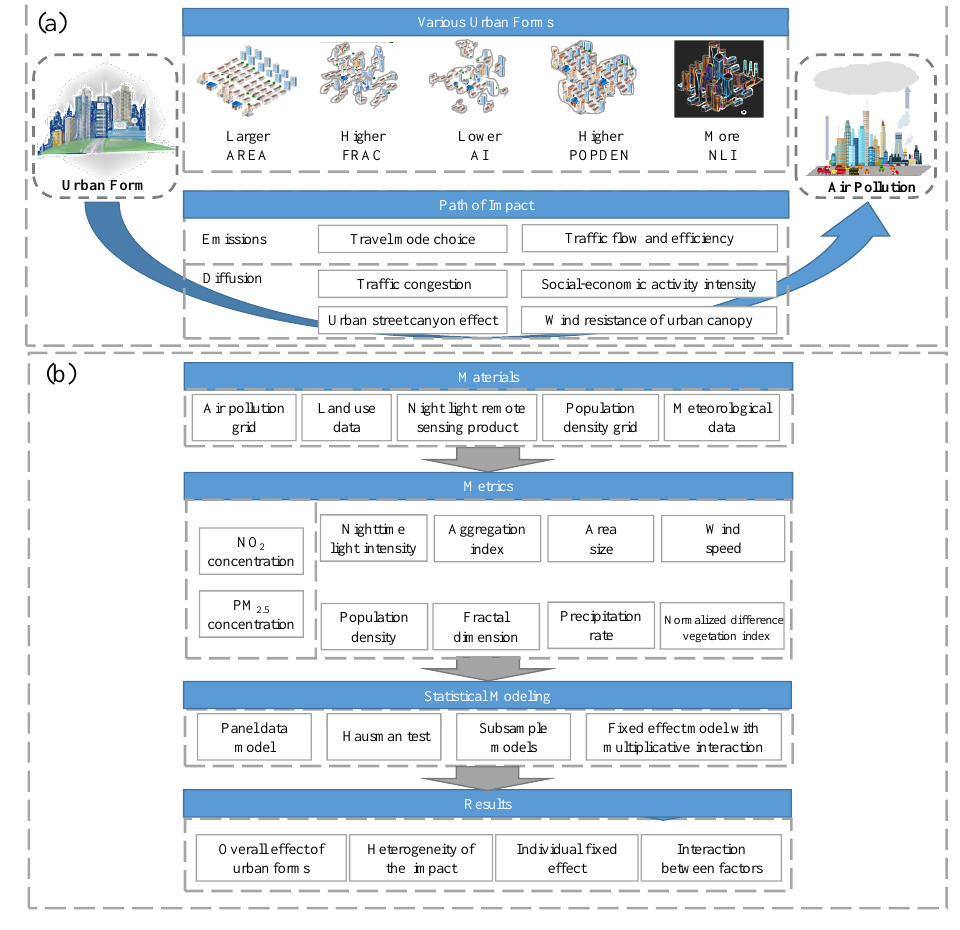
Figure 2. The schematic diagram of the impact paths of urban form on air pollution ( a ) and the method flow ( b ). Table 1. Brief description of the variables.